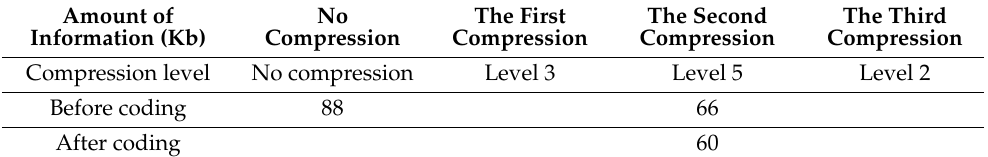
Table 4. Changes in the Amount of Huffman Coding Information after all-level decomposition